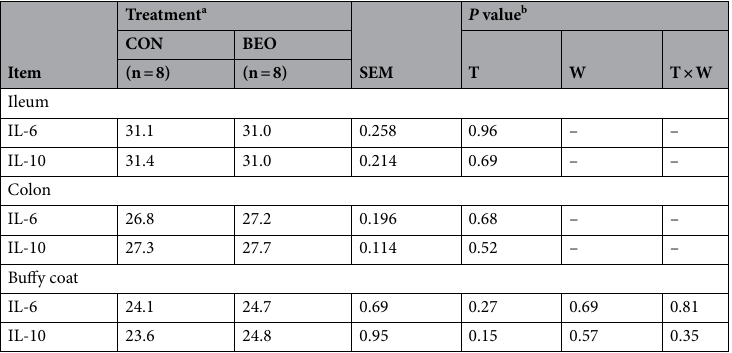
Table 8. Relative gene expression of interleukin 6 (IL-6) and interleukin 10 (IL-10) in control bull calves (CON) and bull calves supplemented with a blend of essential oils (BEO) in milk replacer from 4 to 60 days of age. a CON = control; BEO = 1 g/calf/day blend of essential oil. b T = treatment effect; W = week effect; T × W = treatment by week